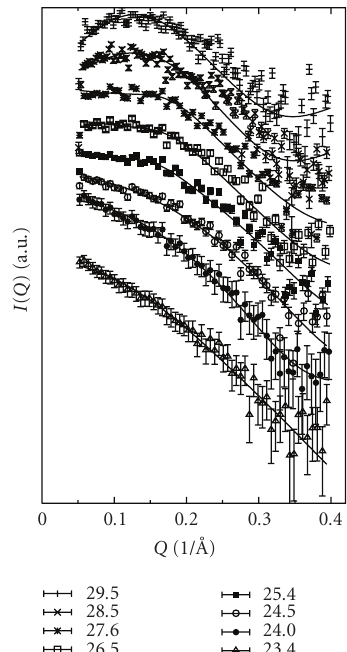
Figure 2: In-solution SAXS profiles observed for d(pG) concentra- tion c = 5 wt% at di ff erent temperatures, as indicated. Best fitting curves obtained using the global fitting approach are shown as solid lines. Note that scattering curves have been scaled by a proper